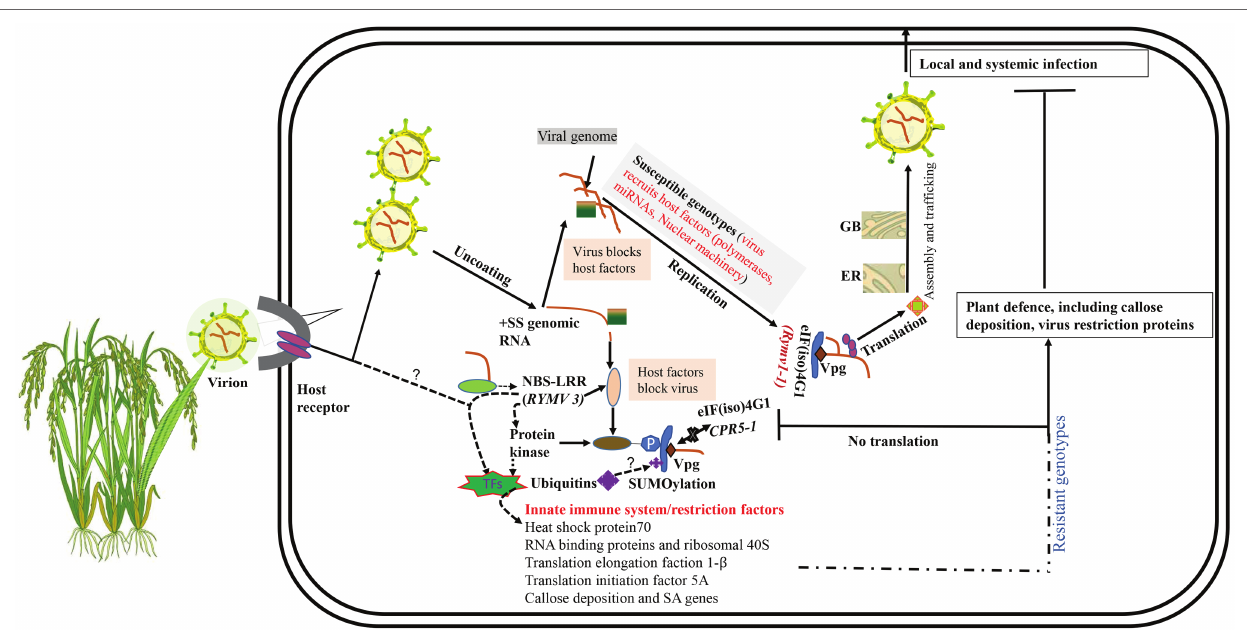
FIGURE 2 | Mechanisms of rice-RYMV interactions. Viruses rely on numerous interactions with the host cell to replicate and transmit. GB, Golgi body; ER, endoplasmic reticulum. Unknown hypotheses are indicated as “?.” In a susceptible interaction, a virus attaches, un-coats, replicates, and expresses proteins, and then assembles and egresses. eIF(iso)4G1 encoded by rymv1-1 (susceptibility allele) possesses altered sites that facilitates viral RNA Vpg binding for successful translation of viral proteins. In a resistant reaction, we hypothesize that when the virus enters the plant cell, viral RNAs or its associated molecules in the cytoplasm are recognized by NBS-LRR or unknown receptors. The signal is transmitted from NBS-LRR via transcription factors (TFs) to the nucleus where induced resistance genes that limit viral replication, translation, and movement are transcribed. NBS-LRR proteins could be activated by direct recognition of the viral RNA. The signal could also be transmitted via either protein kinase monomers or dimers upon binding to viral RNA, which phosphorylates eIF(iso)4G1, thereby leading to translation suppression. Ubiquitination and SUMOylation could also play a role in translation regulation of